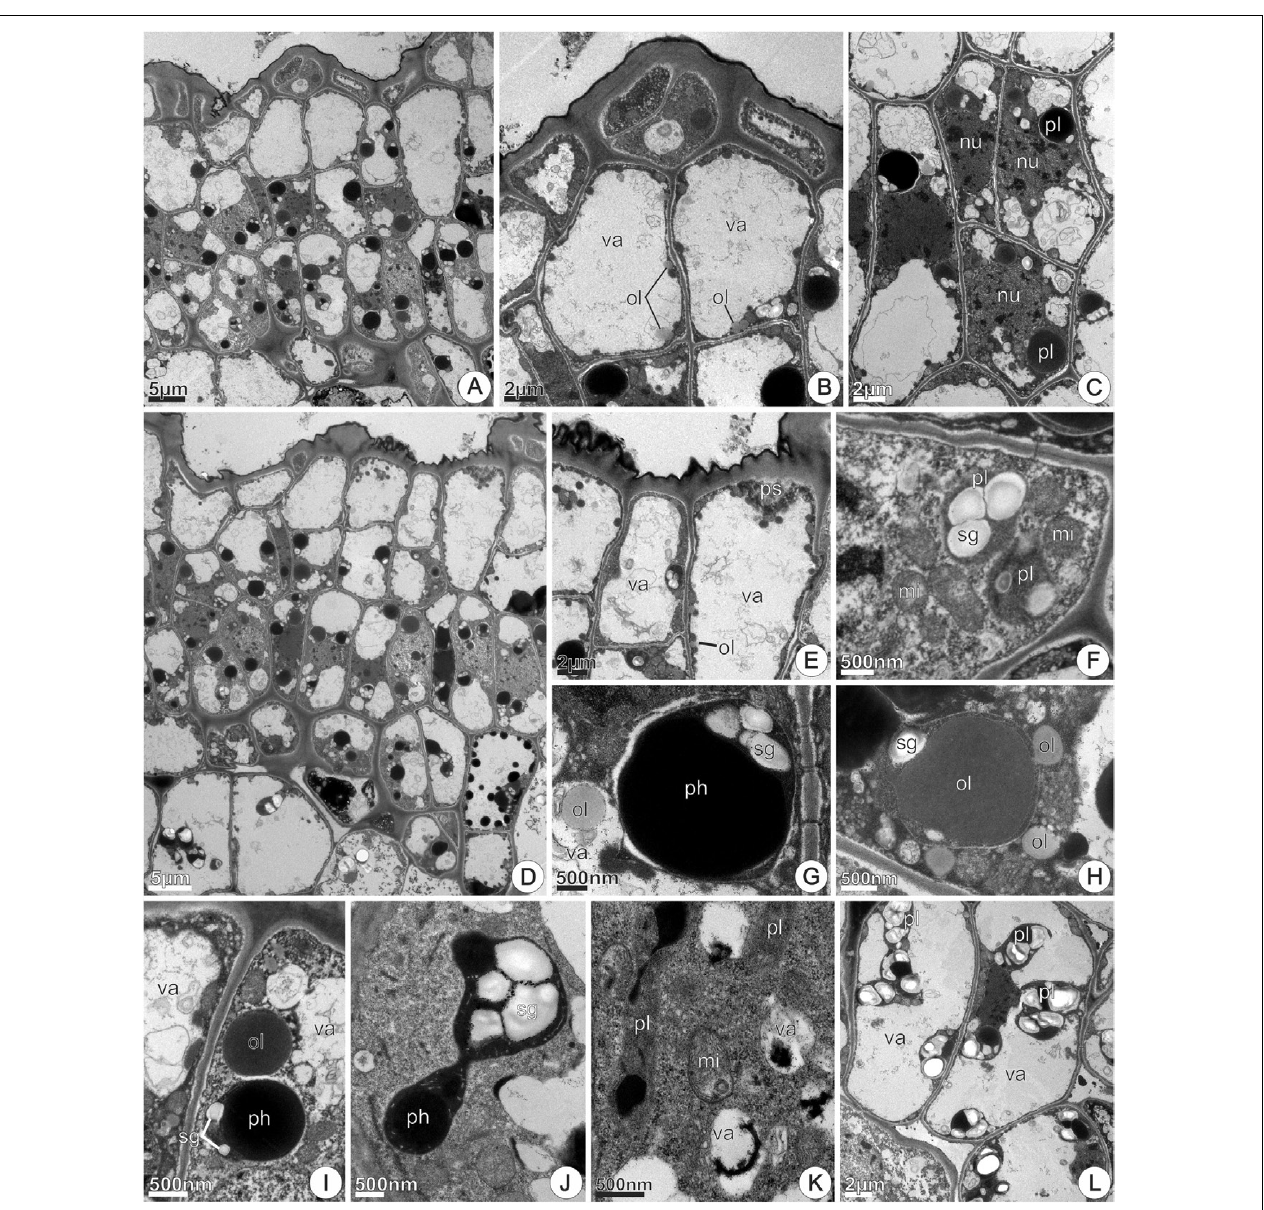
FIGURE 11 | TEM micrographs of the disk from Jacaranda oxyphylla nectarless flowers. (A–C,F) At 0 h of anthesis. (A) General view showing irregular epidermis and juxtaposed subepidermal cells; (B) detail of (A) highlighting epidermal cells with dense cytoplasm, highly vacuolated subepidermal cells and osmiophilic inclusions facing the inner surface of the tonoplast; (C) cluster of three newly derivate subepidermal cells showing voluminous nucleus and rounded plastids with dense inclusions. (D,E,G–L) At 24 h of anthesis. (D) General view showing vacuolated parenchyma cells interspersed with detached epidermal cells; (E) detail of (D) showing osmiophilic droplets inside vacuole and periplasmic space besides secretions on the cuticle; (F) amyloplast with globular starch grains and large mitochondria; (G) rounded plastid containing small starch grains and phenolic content, and lipid drop in the vacuole; (H) oval plastid filled with lipid content from which oil drops flow toward the cytoplasm; (I) large oil drop near plastid with reduced starch grains; (J) dimorphic plastid with starch grains and phenolic content in the opposite poles, showing a constriction in their median region; (K) undifferentiated plastids and vacuoles containing dense inclusions; (L) general view of subnectary parenchyma showing vacuolated cells with prominent amyloplasts. mi, mitochondria; nu, nucleus; ol, oil; pl, plastid; ph, phenolic content; sg, starch grains; va, vacuole.